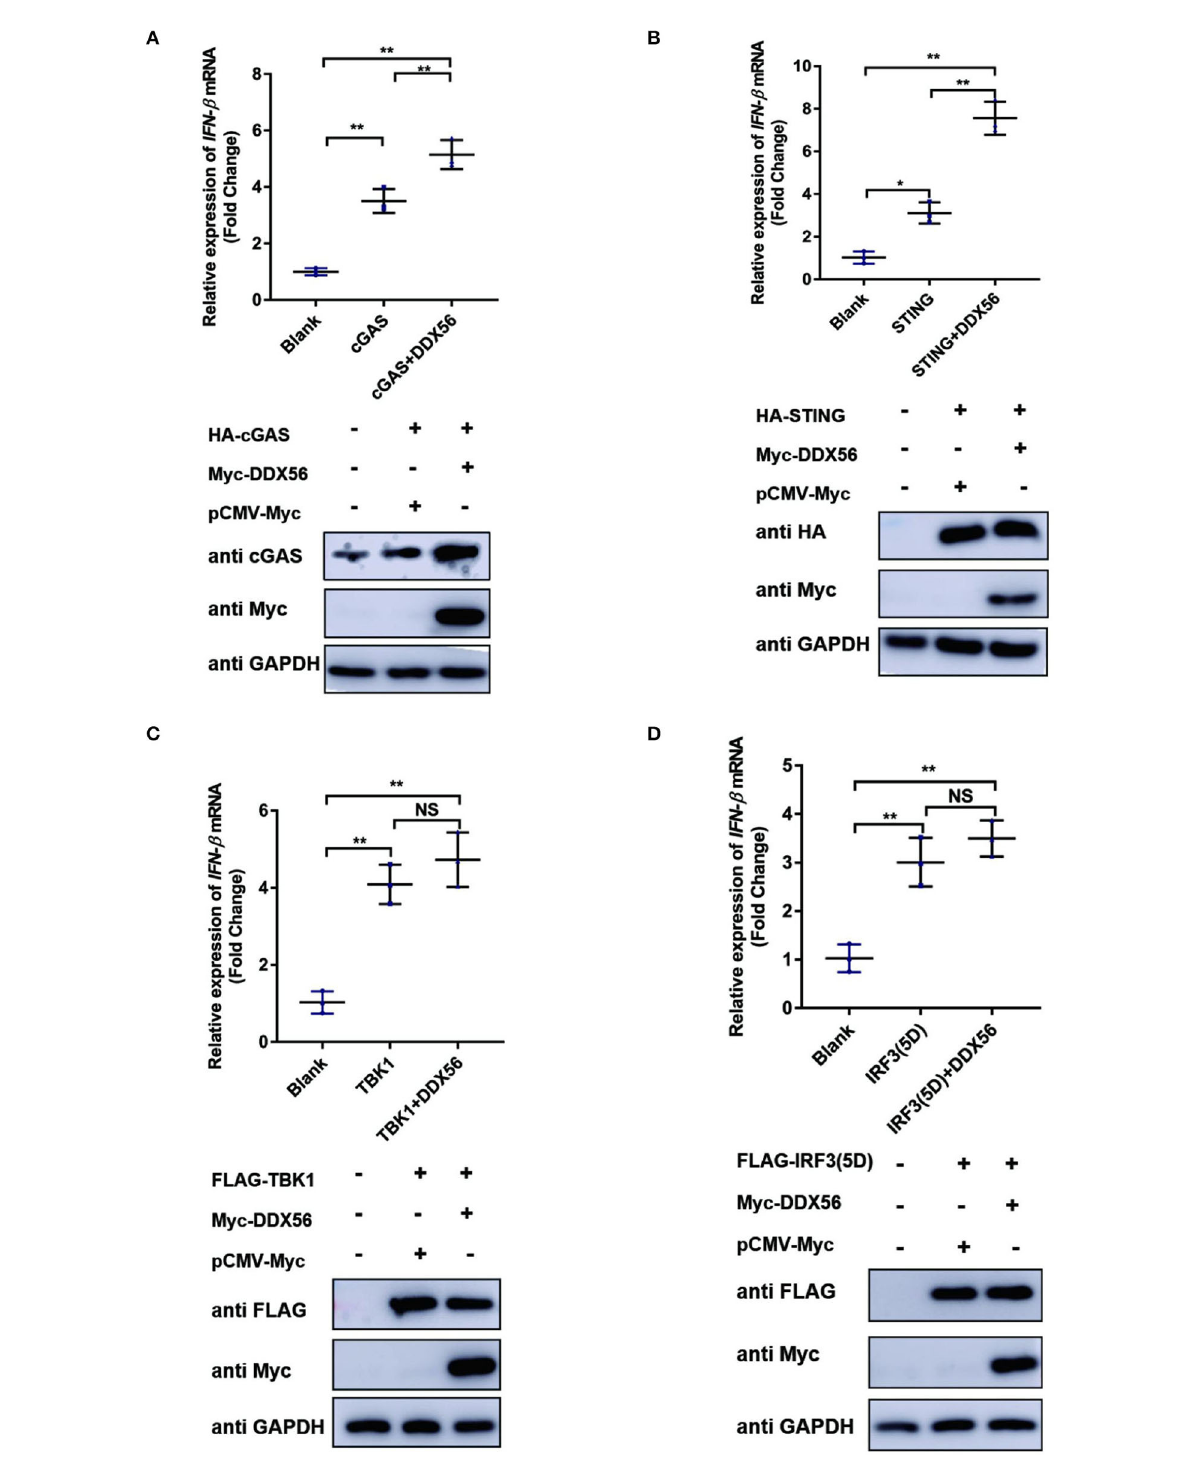
FIGURE5 cGAS might be the potential target of DDX56 protein. In PK15 cells, the empty vector (EV, 1 µ g) or pCMV-Myc-DDX56 plasmids (1 µ g) was co-transfected with indicated plasmids encoding cGAS (250 ng) (A) , STING (250 ng) (B) , TBK1 (250 ng) (C) or IRF3 (5D) (250 ng) (D) for 30h. Then the RNA was extracted and IFN- β levels were determined by RT-qPCR. Western blotting was used to assess the expression of several adaptor molecules as well as the DDX56 protein. GAPDH was used as a loading control. Data were presented as mean ± SD of three independent experiments, measured in technical duplicates. ** p < 0.01 and * p <